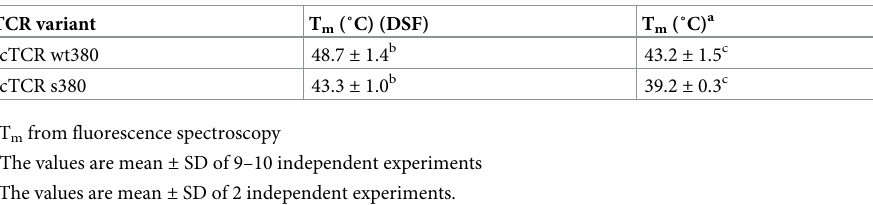
Table 2. TCR stability assessment by DSF and fluorescence